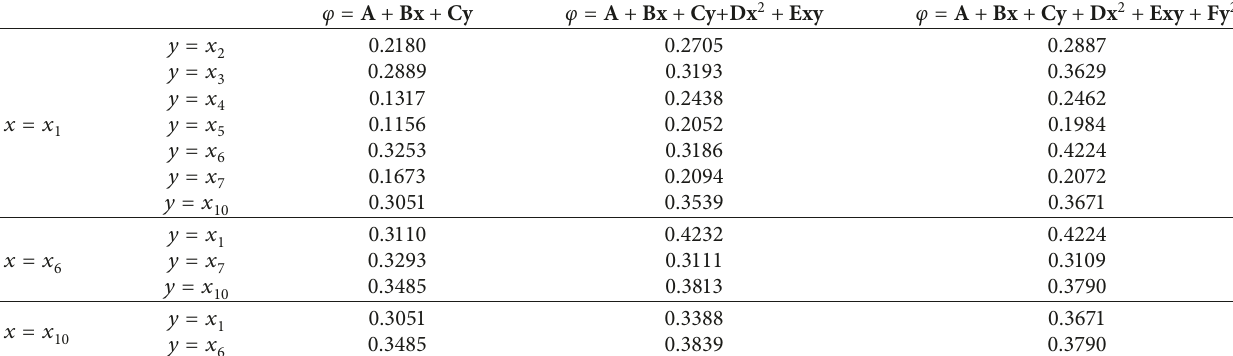
Table 2: Coefficient of determination for the structural capacity factor.